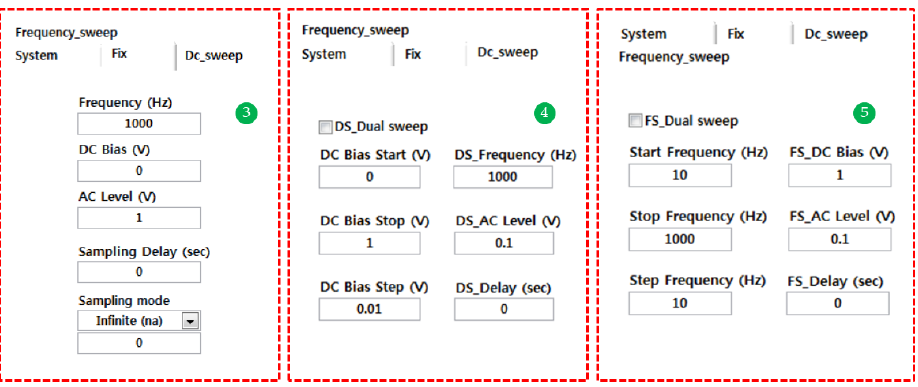
Figure 7. A description of the section numbered 3 to 5 covering the Fix function, DC-Sweep and Frequency Sweep respectively.